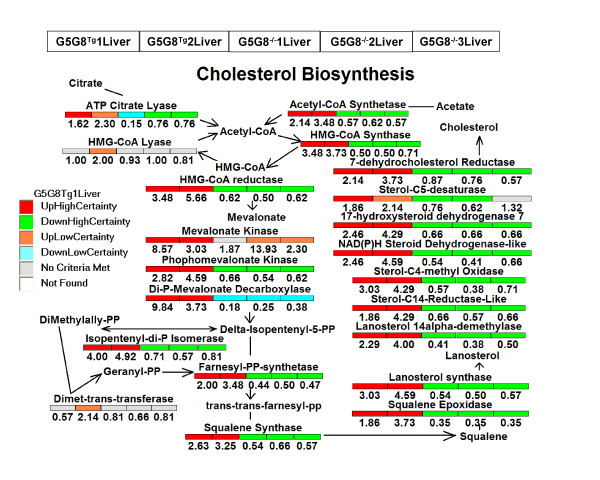
An example of PSCP files in which multiple microarray datasets were analyzed simultaneously. When the pathway tag labeled as 'Cholesterol Synthesis' in Fig. 3 is clicked, the PSCP file is accessed. The numbers displayed proximal to the gene tags (or divided boxes) are the fold changes of the specific genes.